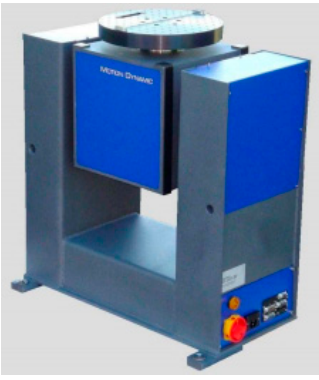
Figure 1. The turntable MOTION DYNAMIC TES-3T.